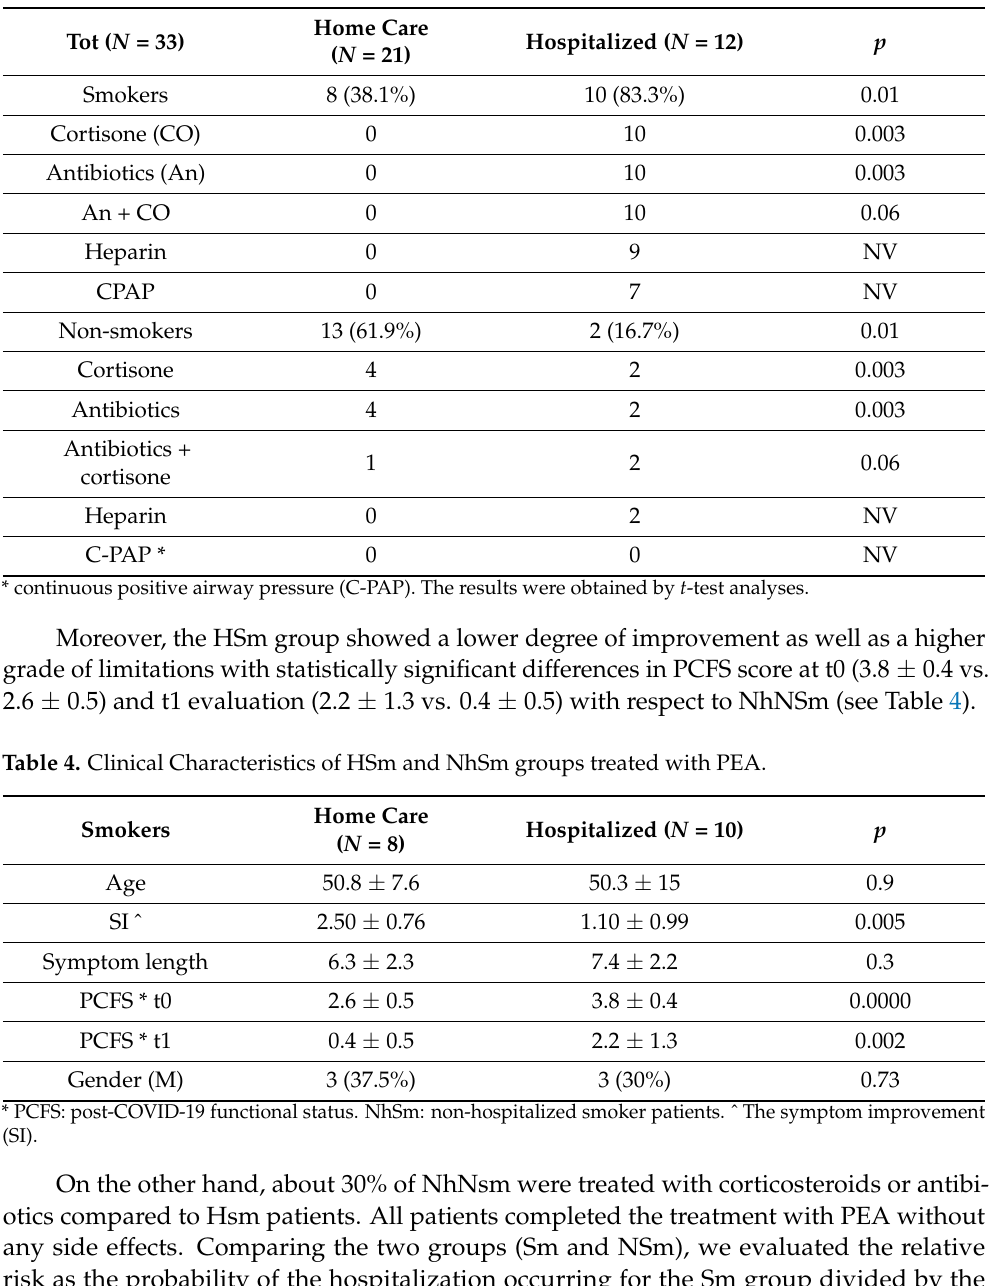
Table 3. PEA treatment differences between (Sm) and non-smokers (Nsm), hospitalized vs. home care.